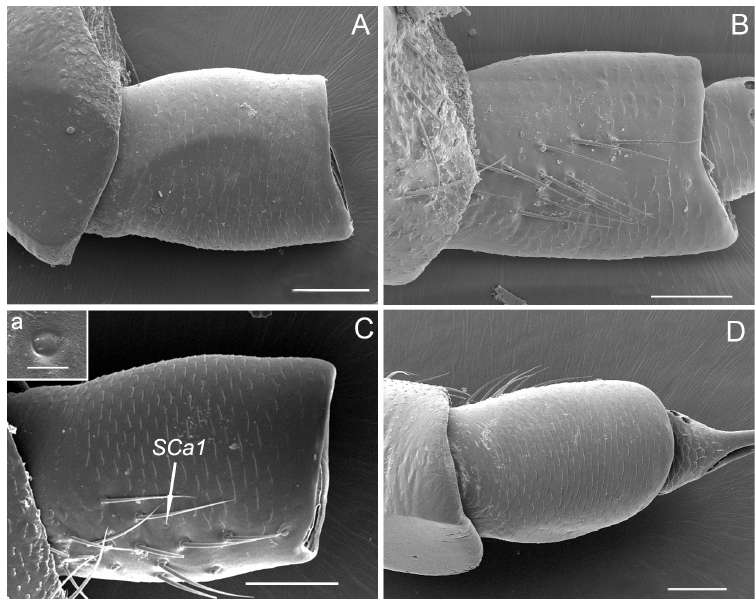
Figure 3. SEM micrographs showing the pedicel of adult Callitettix versicolor (Fabricius) right antenna. ( A ) Ventral view; ( B ) Right lateral view showing sensilla trichodea (ST); ( C ) Dorsal view, a. high magnification image of SCa1; ( D ) Left lateral view. Scale bars: A, B, C, D = 50 μm; a = 5 μm.